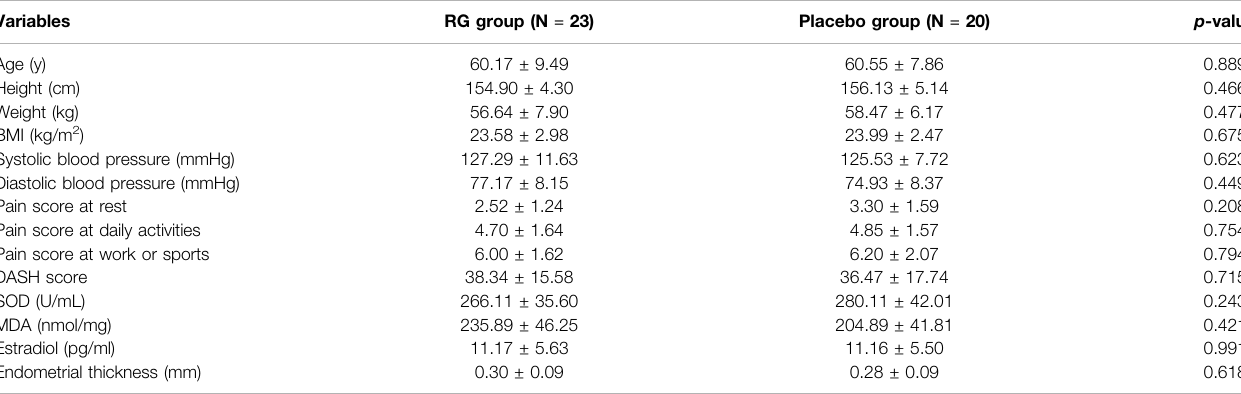
TABLE 4 | Baseline demographic and clinical characteristics of participating postmenopausal women.